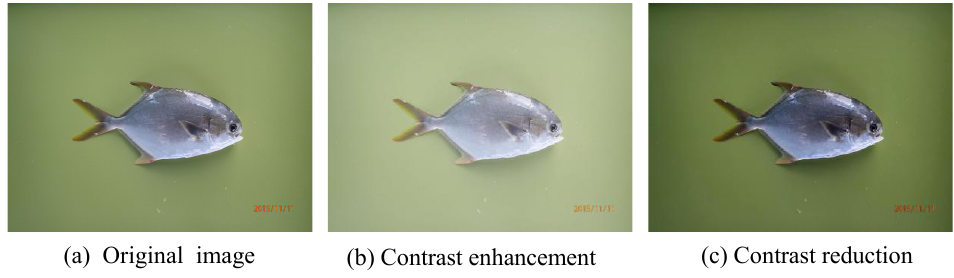
Fig. 3. Effect of the contrast transformation. Figure 4. Data augmentation by contrast transformation.